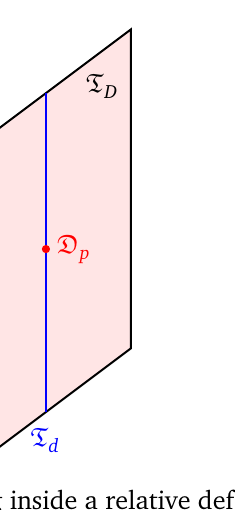
Figure 6: The action of a p -form symmetry lute theory T Λ is obtained by braiding a topological defect α d ∈ L topological defect α of the TQFT S p p + 1 α and descends from α . (cid:98) p d − p − 2